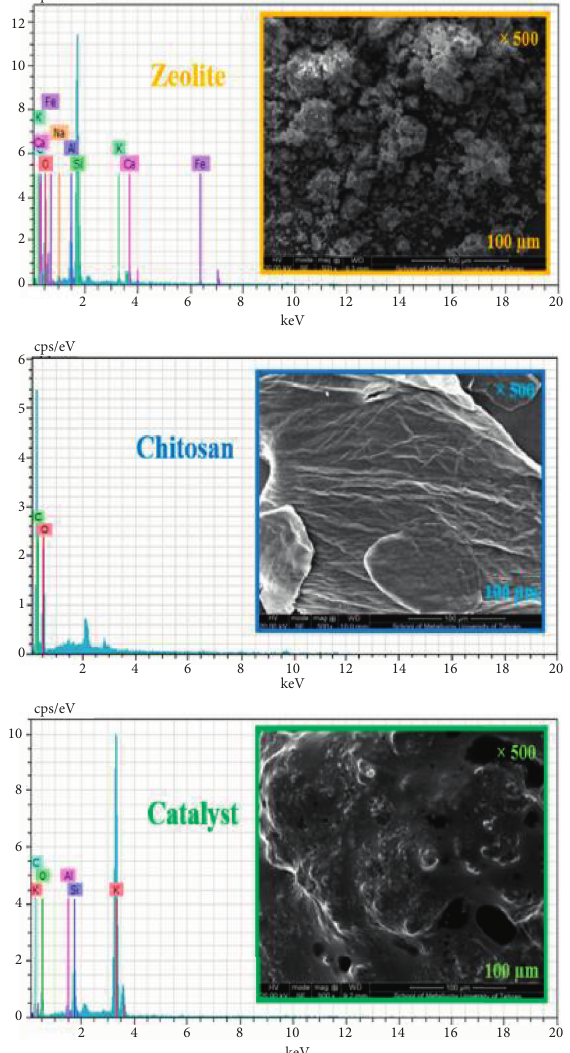
Figure 8: SEM micrographs and EDX spectra of raw zeolite, pure chitosan, and modified zeolite/chitosan/KOH catalyst. Reproduced with permission from [49] copyright 2017,